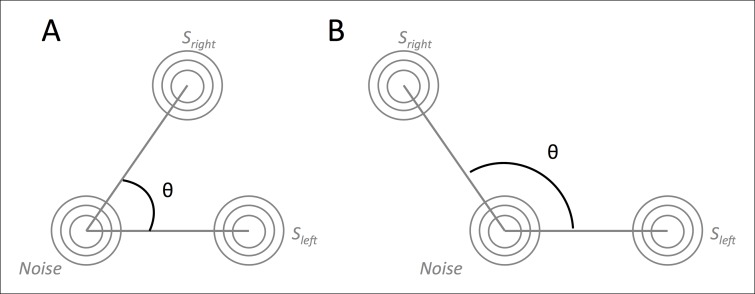
Graphical intuition of correlated stimuli (A) and anti-correlated stimuli (B).